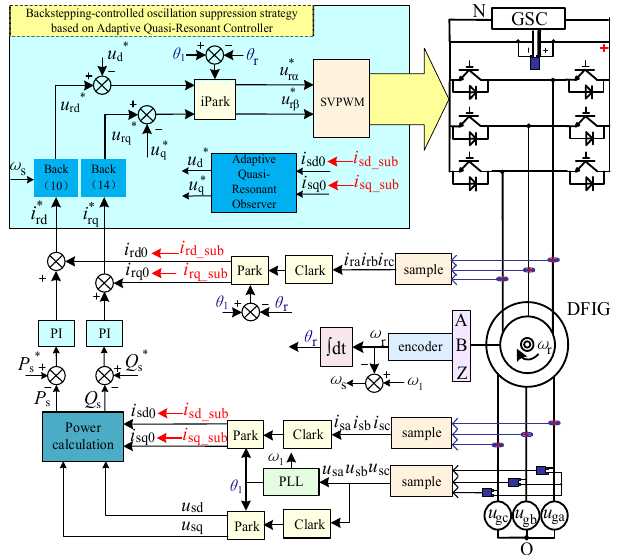
Figure 5. Back-stepping SSO suppression strategy based on adaptive quasi-resonant controller. The synergistic process of the RSC controller and quasi-resonant controller with SSO occurs as follows: when oscillation occurs, the rotor d-axis current (cid:101) i rd and q-axis current (cid:101) i rq containing oscillation components are input into the back-stepping controller and, at the same time, the collected synchronous angular frequency ω 1 and rotor angular frequency realize decoupling control over the DFIG output active and reactive